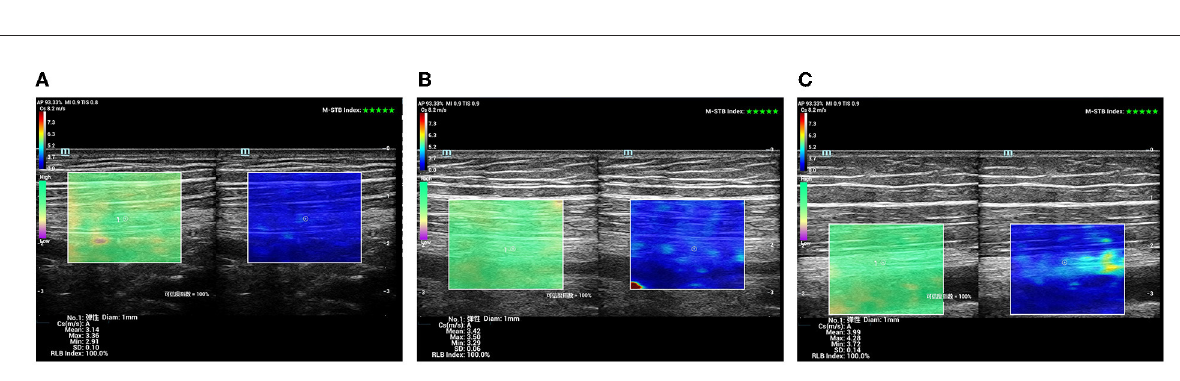
FIGURE4 SWE sonogram of the SN. (A) Control subject; (B) patient with T2DM, non-DPN group; (C) patient with T2DM, DPN group.